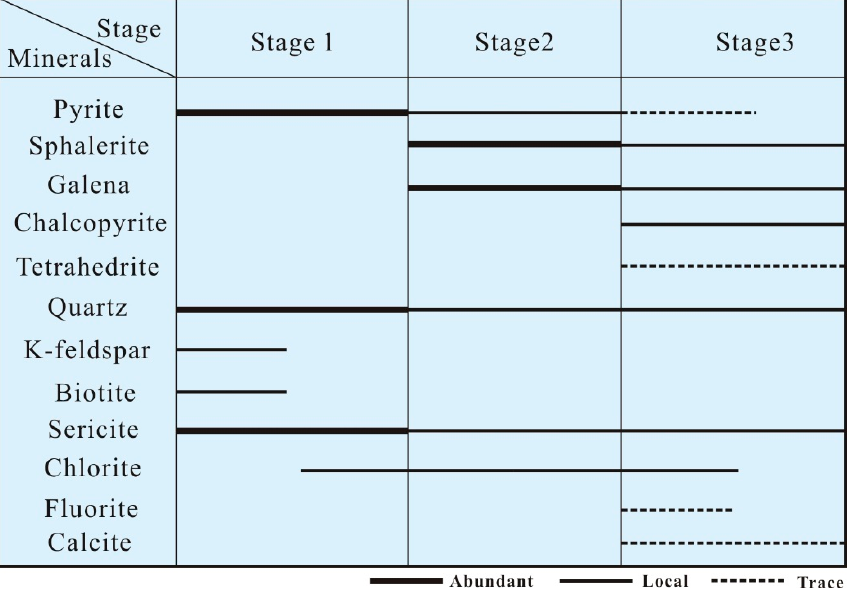
Figure 5. Paragenetic sequence of minerals from the Xiajinbao deposit.